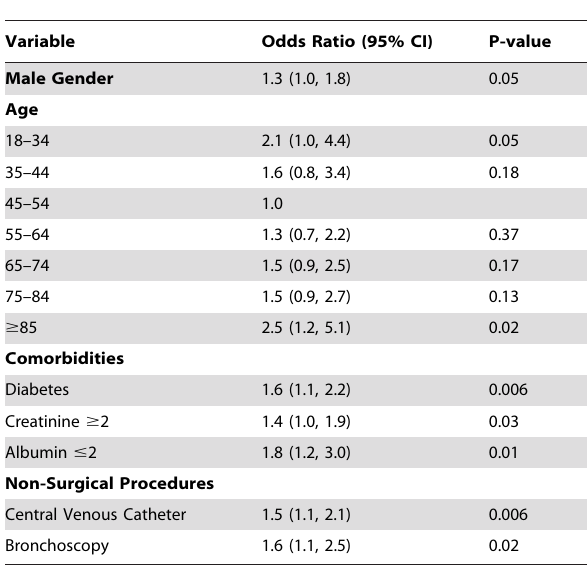
Table 4. Variables associated with Methicillin-Resistant Staphylococcus aureus (MRSA) Infection in the Year Following Detection using Multivariate Logistic Regression